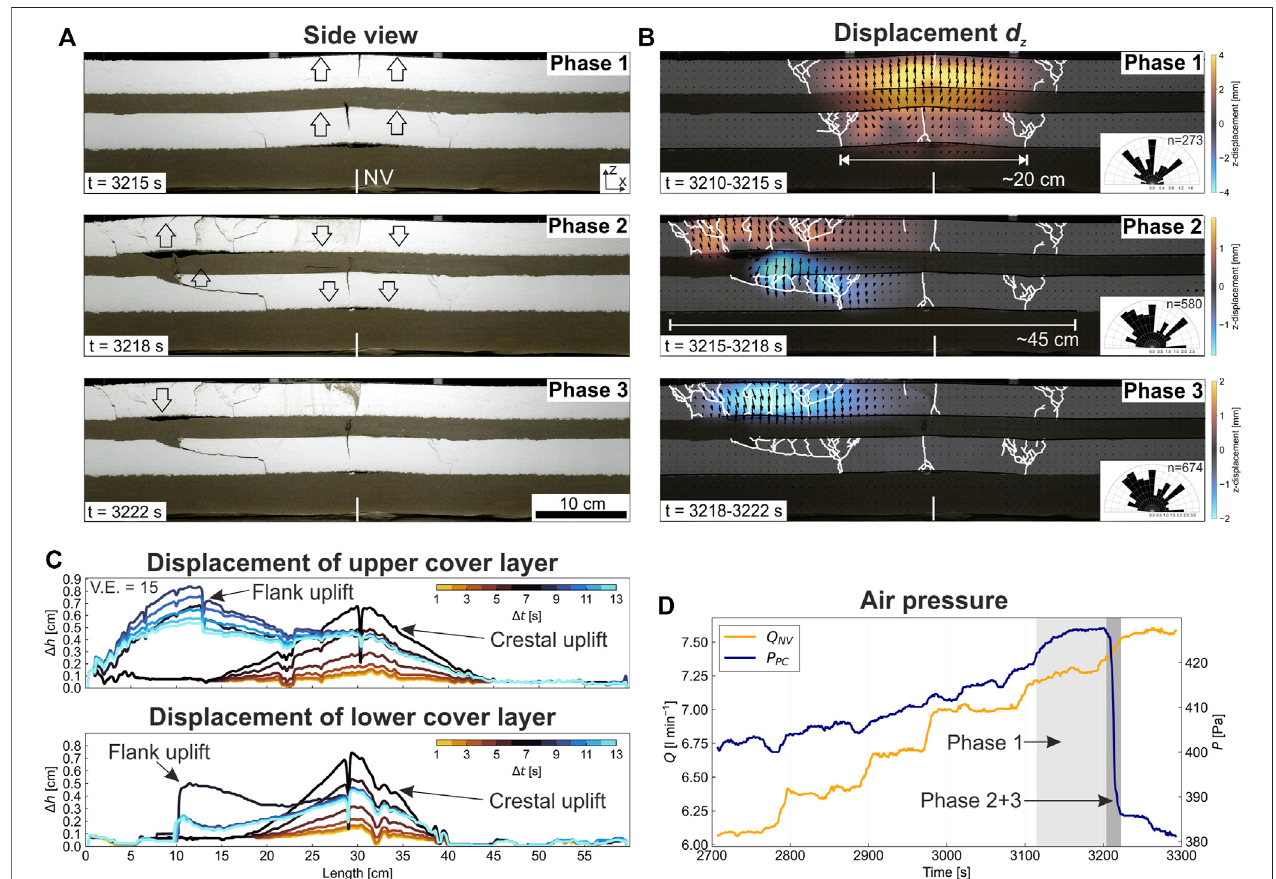
FIGURE6| Resultsofexp.2A,whichconsistedofamulti-layeredcoverandwasperformedinthe2Dcon fi gurationoftheapparatus. (A) Sideviewphotosshowing the structural evolution. Phase 1: a central forced fold developed in both cover layers above the tip of the needle valve (NV). Phase 2: forced folding and fracturing occurred at the left fl ank, whereas the central forced fold subsided. Phase 3: The uplifted parts at the left fl ank gradually subsided. (B) Displacement vector fi eld derived fromtheDICanalysis.Thebackgroundcolordisplaystheamountoftheverticaldisplacement d z (uplift=orangetobrown,subsidence=browntoblue).Eachimage shows the cumulative displacement for the speci fi ed time interval. The fracture segments (white lines) were interpreted from high-resolution photos ( see e.g. Figure 3 ). The rose diagrams show the dip directions normalized by the lengths of individual fracture segments. (C) Time series of the elevation of the upper and the lower cover layerplottedagainstthex-positionoftheexperiment. (D) Timeseriesoftheair fl uxthroughtheneedlevalve( Q NV )andthepressureinthepressurechamber( P PC ).Air fl ux at the base of the pressure chamber ( Q PC ) was constant so that P PC was approx. 40% of the total vertical normal stress at the beginning of the experiment ( Table 1 ).